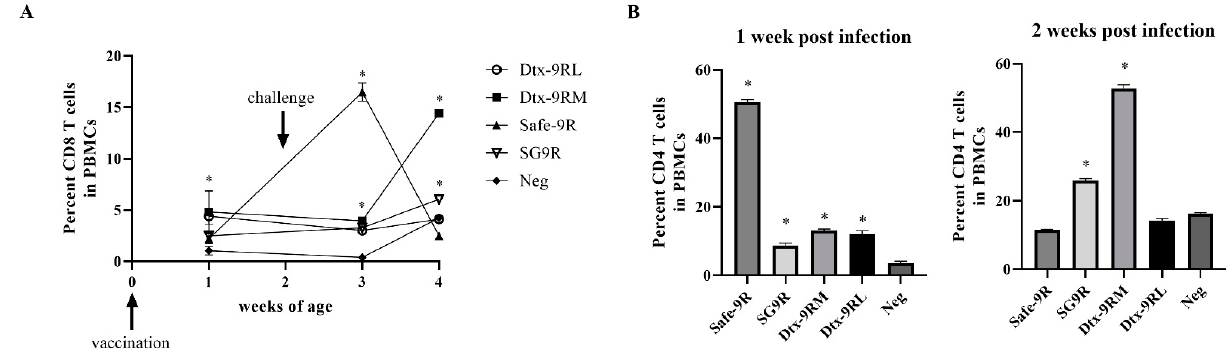
Figure 7. Proportion of CD8+ T cells in peripheral blood mononuclear cells (PBMCs) determined by fluorescence activated cell sorting. Detoxified vaccines were inoculated in 1 day-old chicks and the whole blood samples were collected in heparin-containing tubes. The samples were pooled by group and PBMCs were isolated. The percentage of ( A ) CD8+ T cells and ( B ) CD4+ T cells were analyzed. * Indicates a significant difference compared with Neg ( p < 0.05).